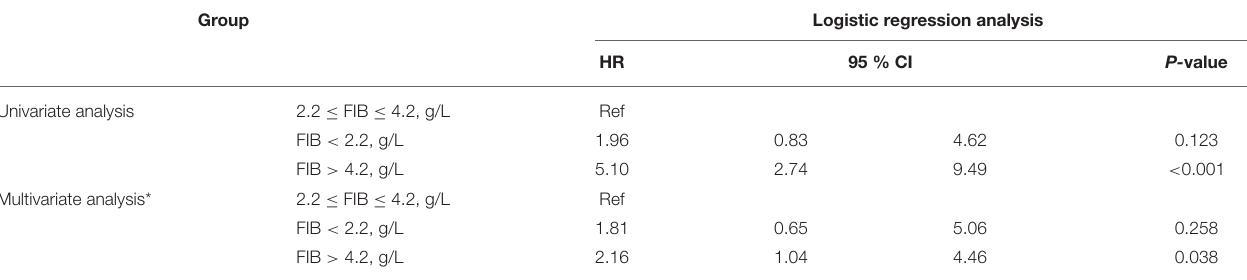
TABLE 4 | Univariate and multivariate logistic regression analysis for critical disease in patients with COVID-19. Group Logistic regression analysis HR 95 % CI P- value Univariate